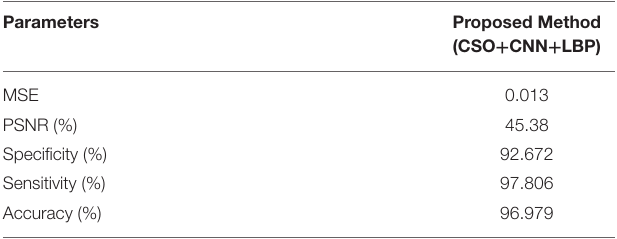
TABLE 1 | Attributed obtained from the proposed method.